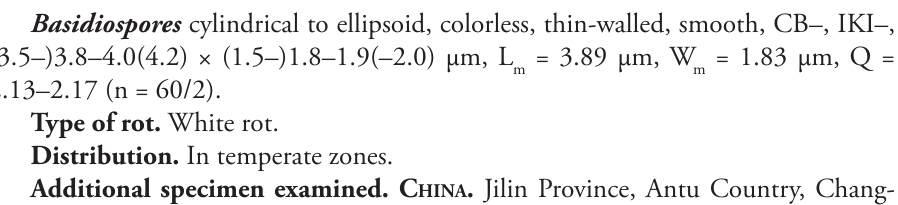
= 3.89 μm, W = 1.83 μm, Q = m m